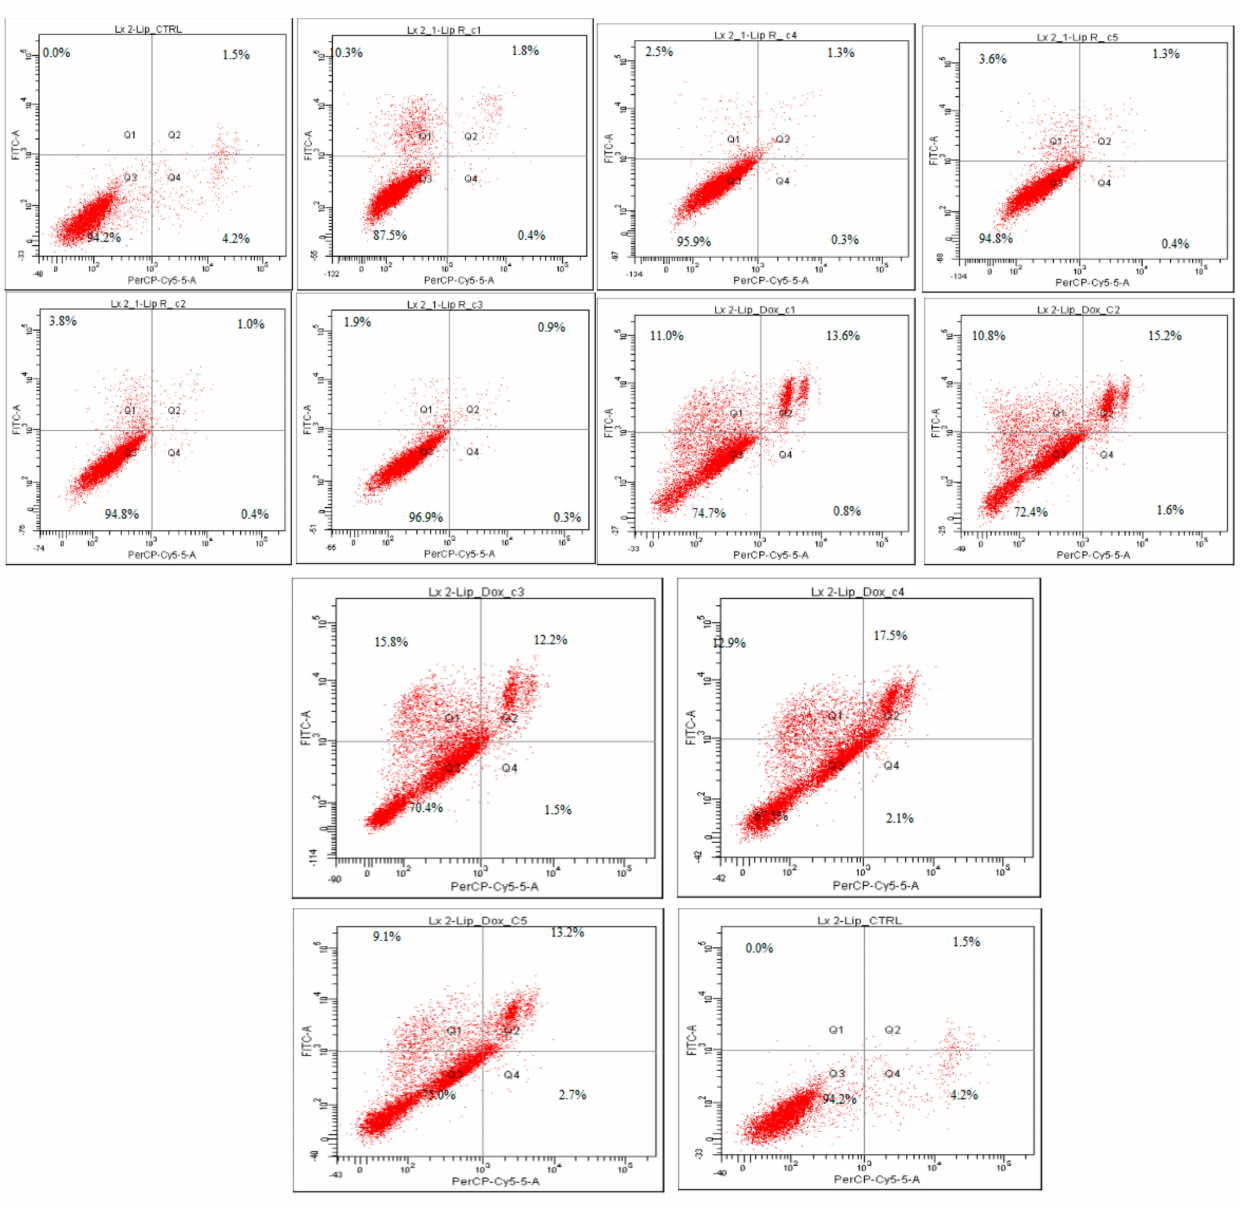
Figure 3. Apoptosis evaluation in LX2 cells (10,000 events) after treatment with L-R and L-DOX. After 24 h of treatment, the cells were stained with Annexin V-FITC and Ethidium Homodimer III (EthD-III) and were evaluated using the BD FACS Canto II flow cytometer (Becton Dickinson, Franklin Lakes, NJ, USA) using the BD FACSDiva 6.1.2 software. The results are shown in dot plots divided